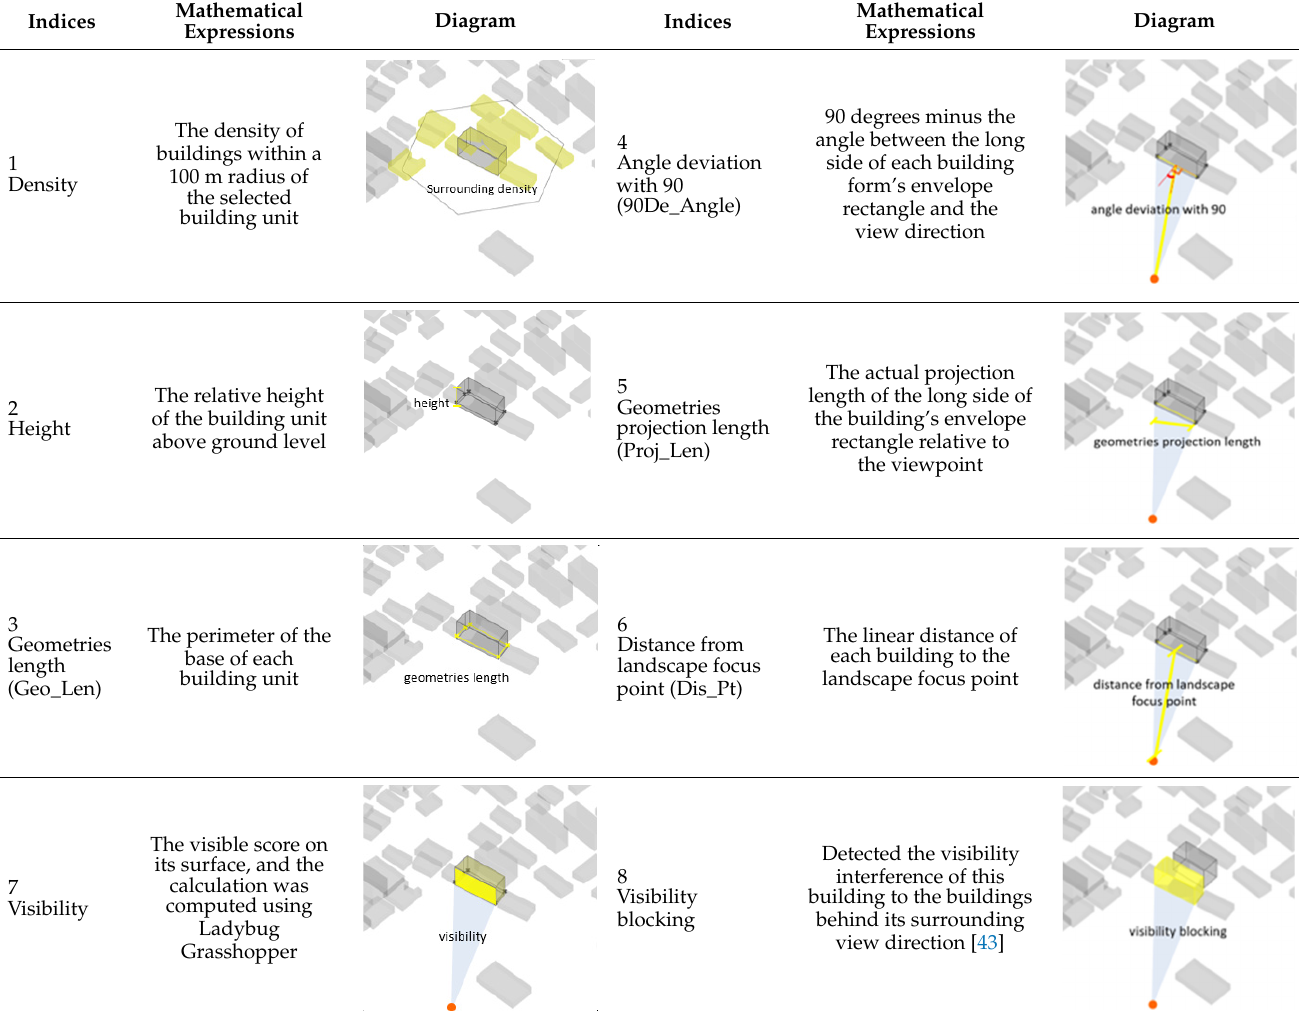
Table 5. Measurement indices [43].